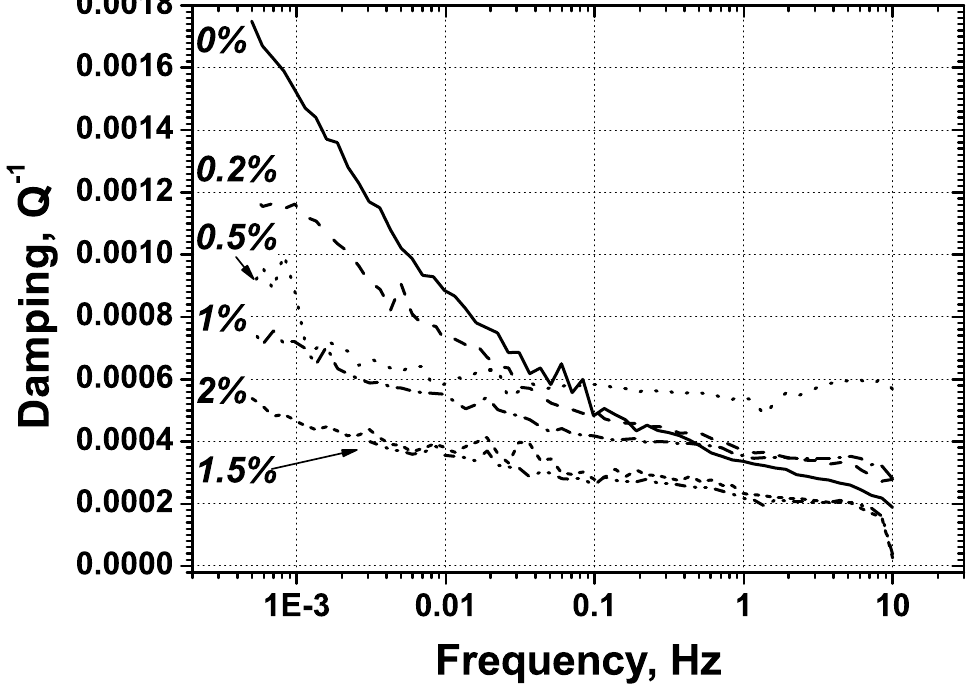
Figure 17. Internal friction measurement for the TRIP5 steel with the prestrains in the range of 0–2%.